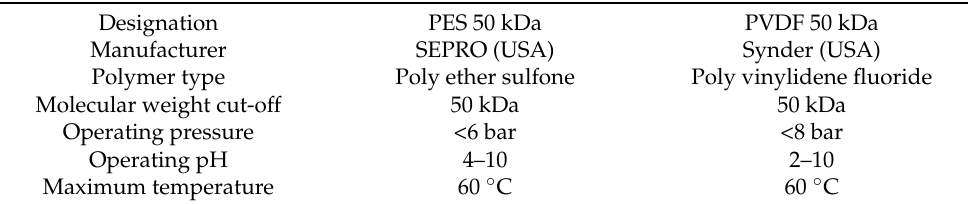
Table 2. Characteristics of UF membranes.